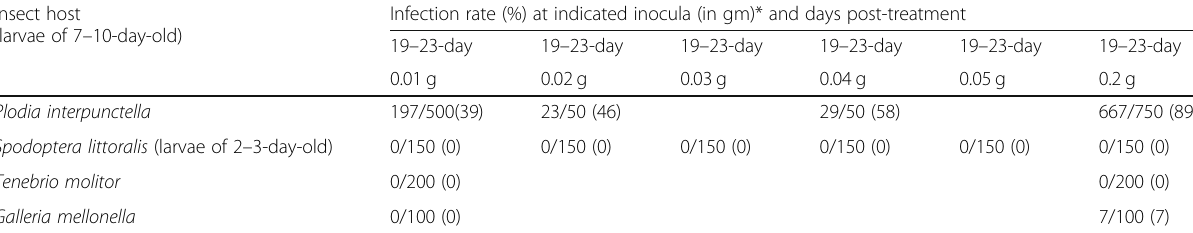
Table 4 Propagation of Mattesia sp. isolated from Laemophloeus turcicus adults in alternate larger insects at indicated inocula and days